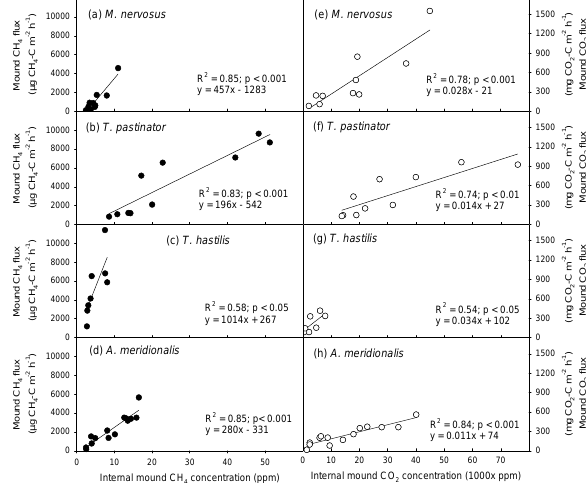
Fig. 4. Relationships of CH 4 and CO 2 internal mound concentra- tions with respective CH 4 and CO 2 mound Figure 4: Relationship of CH 4 and CO 2 internal mound concentrations with respective CH 4 690 and CO 2 mound fluxes 691